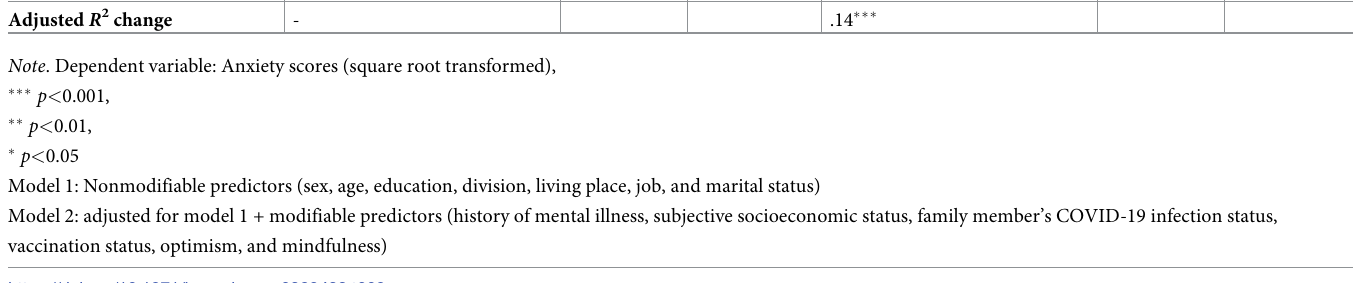
a significant increase of 25% variances attributable to modifiable factors. In the fully adjusted